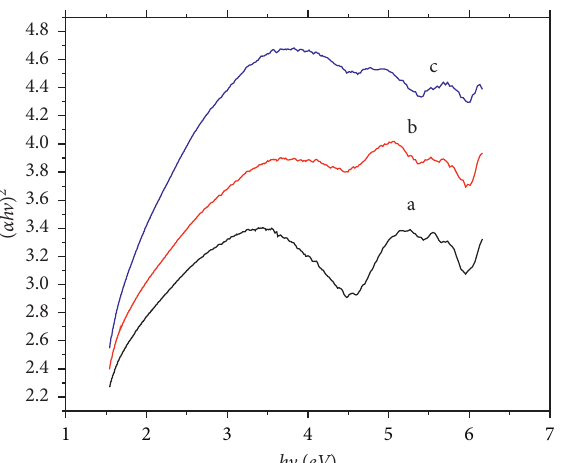
Figure 7: Tauc plots of CuO NPs synthesized using copper (II) nitrate trihydrate and Catha edulis leaf extract in (a) 1:10, (b) 3:10, and (c) 1: 2 ratios (w/v).